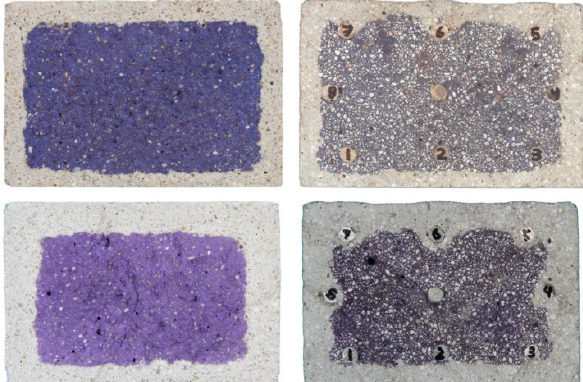
Figure 1. Image series of observed carbonation front detection in sample without ( left ) and with reinforcement ( right ) after application of thymolphthalein solution for ten-week ( top ) and twenty two-week ( bottom ) exposure periods [15].